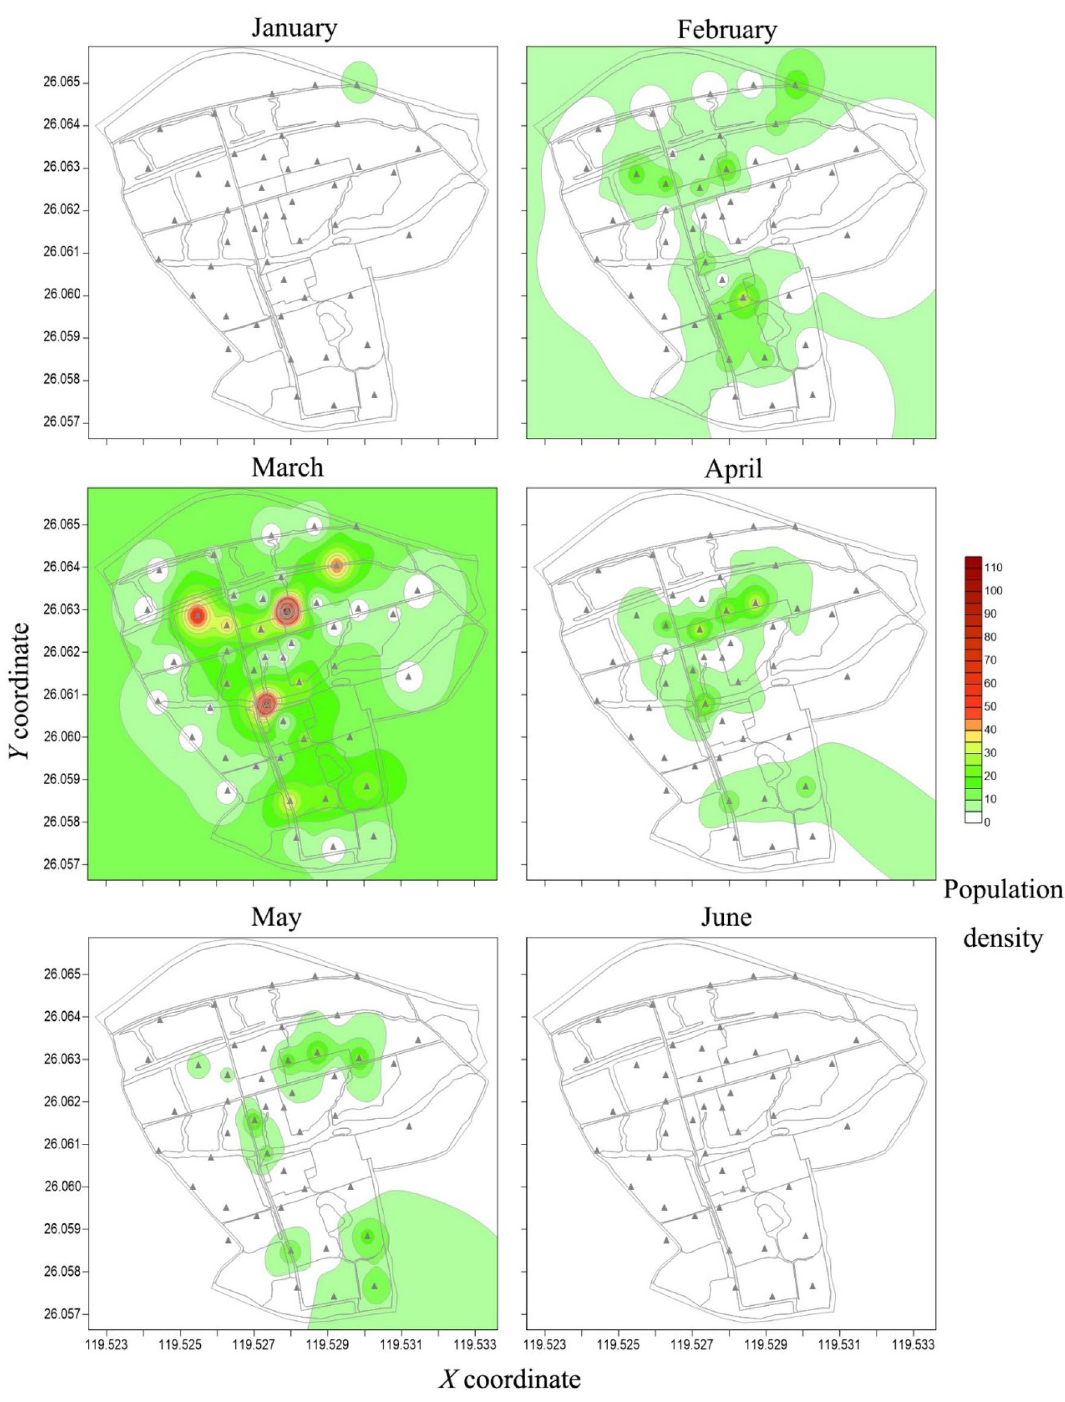
Figure 5. Contour maps of P. xylostella distribution obtained by inverse distance squared weighted procedures applied to the monthly trap counts in 2017 using Surfer v14.0. Trap location in the field is shown by triangles ( ▲ ); X (longitude) and Y (latitude) axes are expressed in UTM